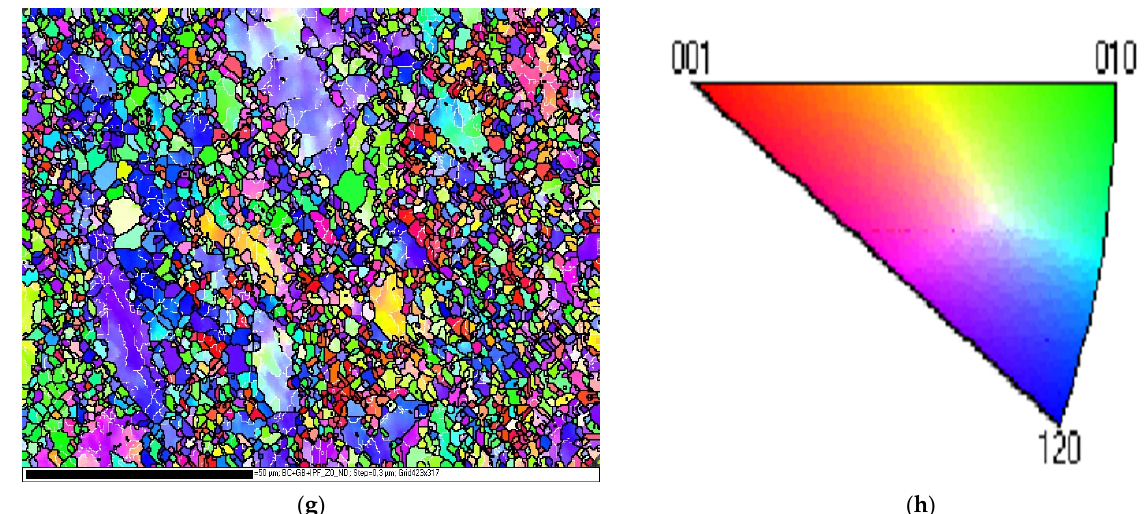
Figure 2. EBSD orientation maps for the AA ‐ ZK30 ( a ) and after the ECAP processing through 1 ‐ P ( b ), 4 ‐ A ( c ), 4 ‐ Bc ( d ), 4 ‐ C ( e ) using the 90° ‐ die and 1 ‐ P ( f ), 4 ‐ Bc ( g ) using the 120° ‐ die and the inverse pole figure (IPF) coloring triangle is shown in ( h ), red: [001]; blue: [120]; and green: [010]. Table 3. Grain size data of the AA and ECAPed Mg ‐ Zn ‐ Zr billets. All units are in μ m.